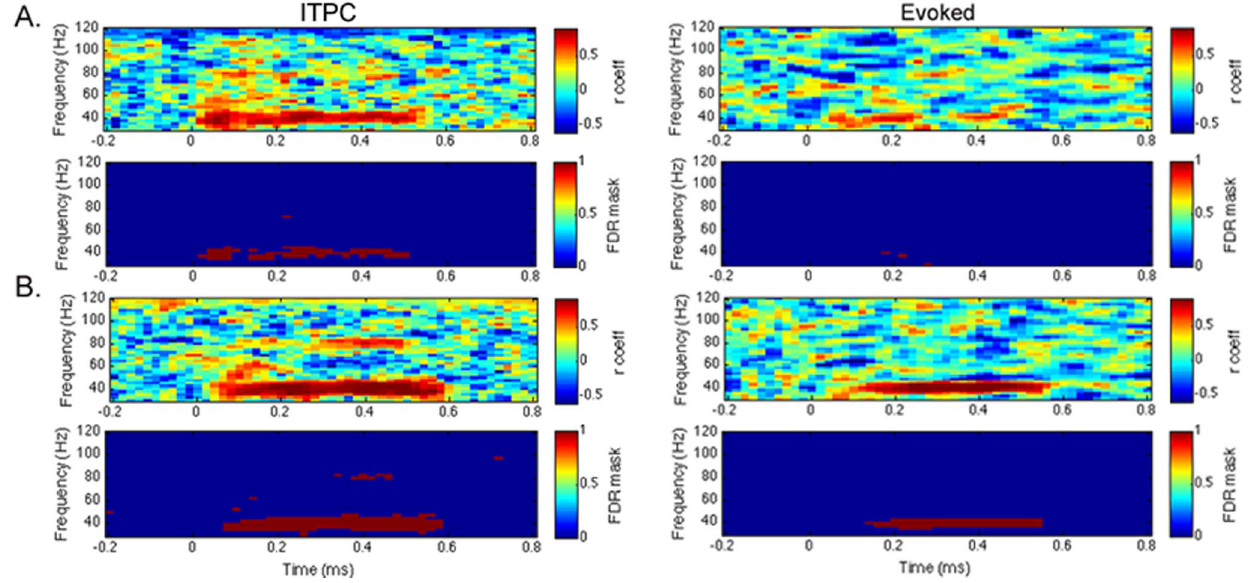
Figure 3. Example of correlation results. Correlation results between sessions 1 and 2 for inter-trial phase coherence (ITPC) and evoked activity for white noise stimuli (A) and click train stimuli (B) for the sensor-level analysis at the channel with the peak 40 Hz auditory steady-state response (FCz). In each plot, the first row shows the correlation coefficient (r coeff) and the second row shows correlations that were significant following multiple comparison correction (FDR, q =0.05; 0/blue = not significant, 1/red =